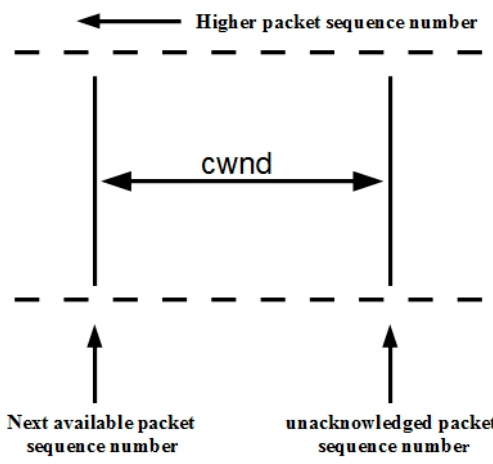
Figure 4. TFWC congestion window mechanism.